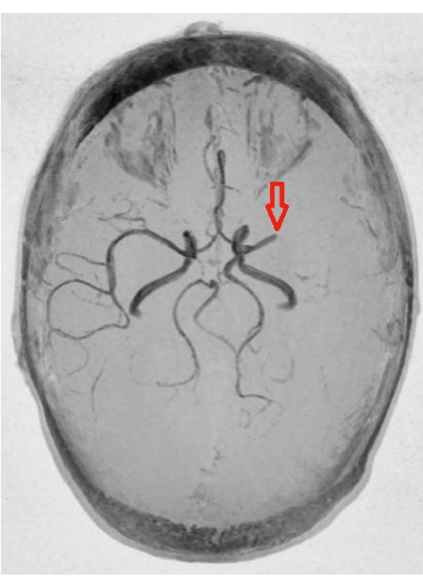
Figure 2: MRA brain showing total occlusion of M1 segment of left MCA (red arrow) and normal circle of Willis.